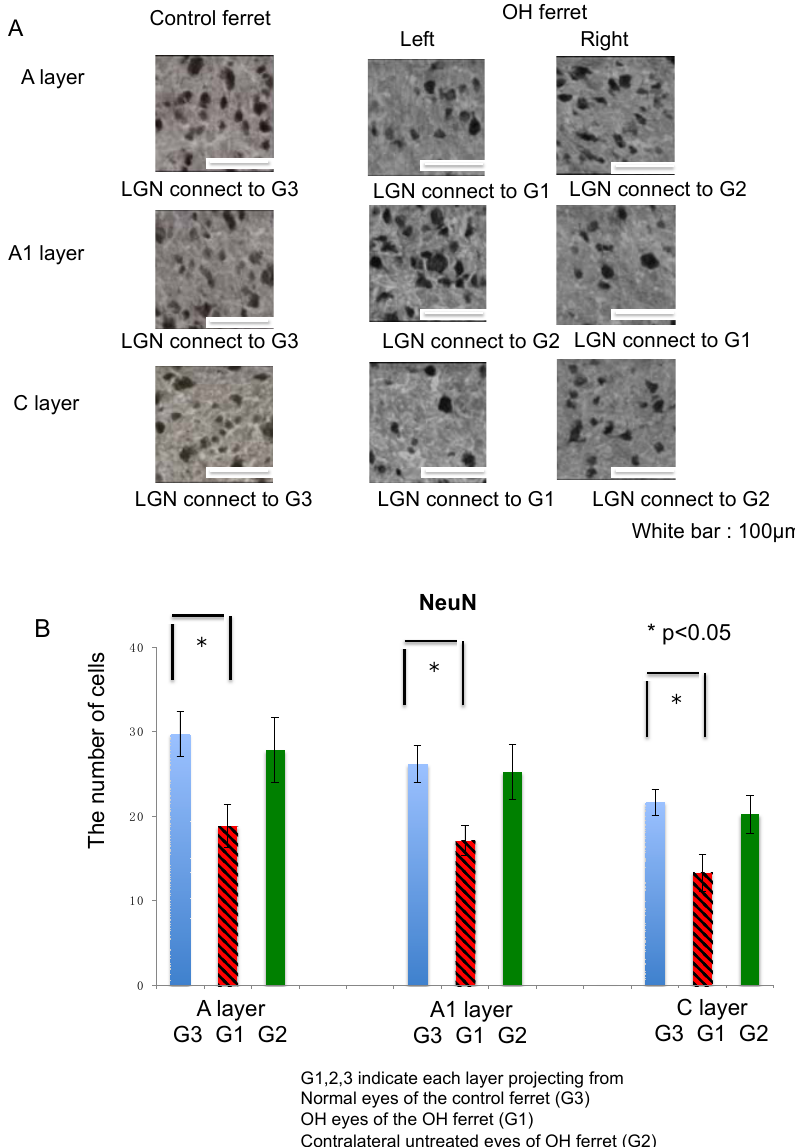
Figure 4. Immunohistological images of neurons in LGN of the OH (G1) and the untreated contralateral eyes (G2) of the OH ferret, and the normal eyes (G3) of the control ferret. ( A ): NeuN staining indicating neuronal cells. (200 µ m × 200 µ m square; white bar = 100 µ m). ( B ) Comparison of neurons in LGN layers projecting from the OH (G1) and the untreated contralateral eyes (G2) of the OH ferret, and the normal eyes (G3) of the control ferret. B: The number of NeuN immunoreactive neuronal cells. Significant decrease of the number of NeuN-immunoreactive cells was observed in A, A1, and C layers of G1, compared with those layers of G3 ( n = 10, paired t -test, p < 0.01).